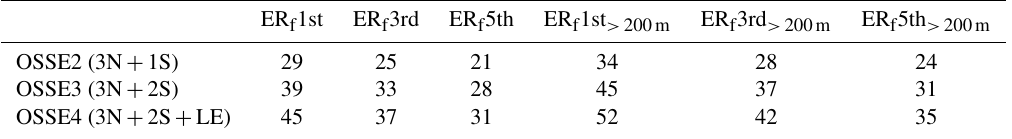
Table 5. SSH ocean forecast error statistics. Columns 1–3 represent the reduction of the variance of error in the ocean forecast (ER f ), with respect to OSSE1 (3N) on the first, third, and fifth day of forecast. Columns 4–6 are the same as columns 1–3, but exclude the shelf areas shallower than 200m (e.g. 1st > 200m ). The legend for the OSSEs is as in Fig. 4. Statistics obtained considering the period from February to December 2009. Values are expressed as percentages.